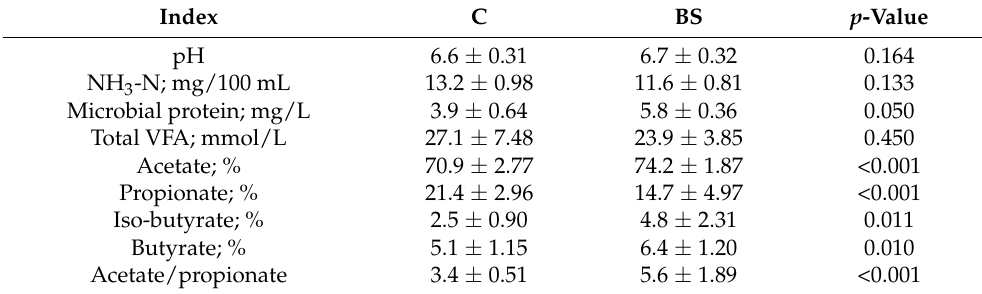
Table 2. pH and concentrations (mean ± SE; n = 5) of ammonia-N (NH 3 -N), volatile fatty acids (VFA), and microbial protein in the rumen fluid of lambs fed basal diet only (Control; C) or basal diet supplemented with Bacillus subtilis at the concentration of 3 × 10 8 CFU/kg DM